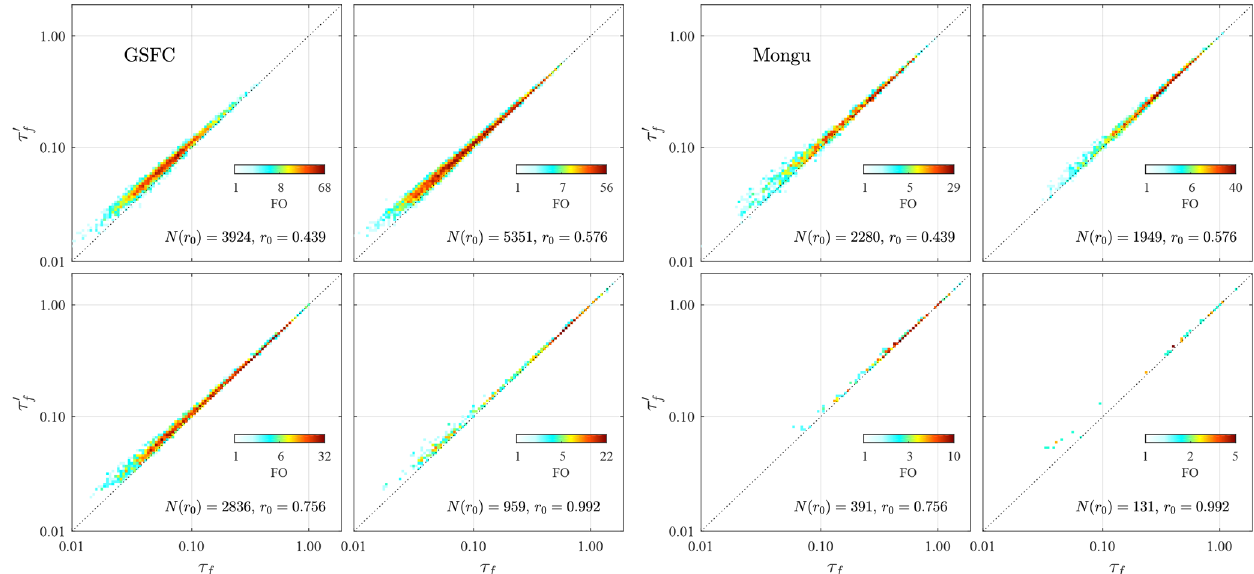
Figure A1. τ (cid:48) vs. τ f frequency of occurrence (FO) distributions for GSFC and Mongu. The FO color scale is tied to variations on a logarithmic f scale (with an attendant tendency to enhance the contributions of large FO values). N(r 0 ) is the total FO at a given r 0 value.